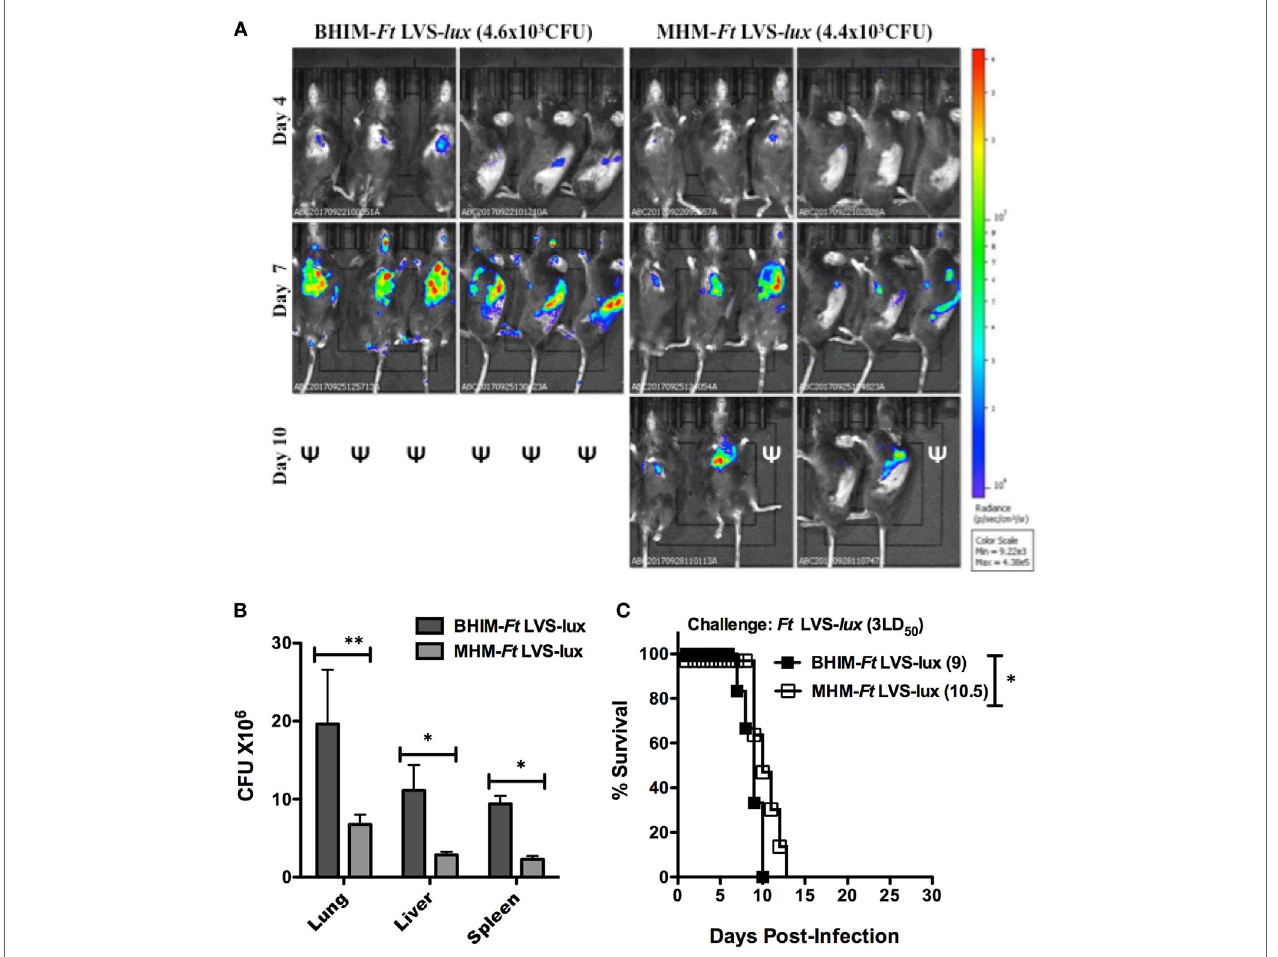
FigUre 1 | Brain-heart infusion medium (BHIM)-grown Francisella tularensis ( Ft ) replicate better in vivo than Mueller-Hinton medium (MHM)-grown Ft . Naïve C57BL/6 male and female mice (3/group) were anesthetized and then infected i.n. with either Ft LVS- lux grown in BHIM or MHM. Dissemination of Ft was monitored using in vivo imaging system Lumina on days 3 through 10 post-infection. Mice were imaged in ventral and side alignments. The image scaling was normalized by converting total counts to photons per second. The scale from blue to red represents low to high radiance efficiency expressed as p/sec/cm 2 /sr. ψ : indicates that mice were dead by the indicated time point post-infection (a) . Two groups of male and female mice were infected i.n. with 3LD 50 BHIM or BHIM- Ft LVS- lux followed by analysis of bacterial burdens in lungs, liver, and spleen 7 days post-challenge (B) . Alternatively, mice were subsequently monitored for survival (c) . Median survival times (days) are specified next to the survival curves. * p < 0.05.